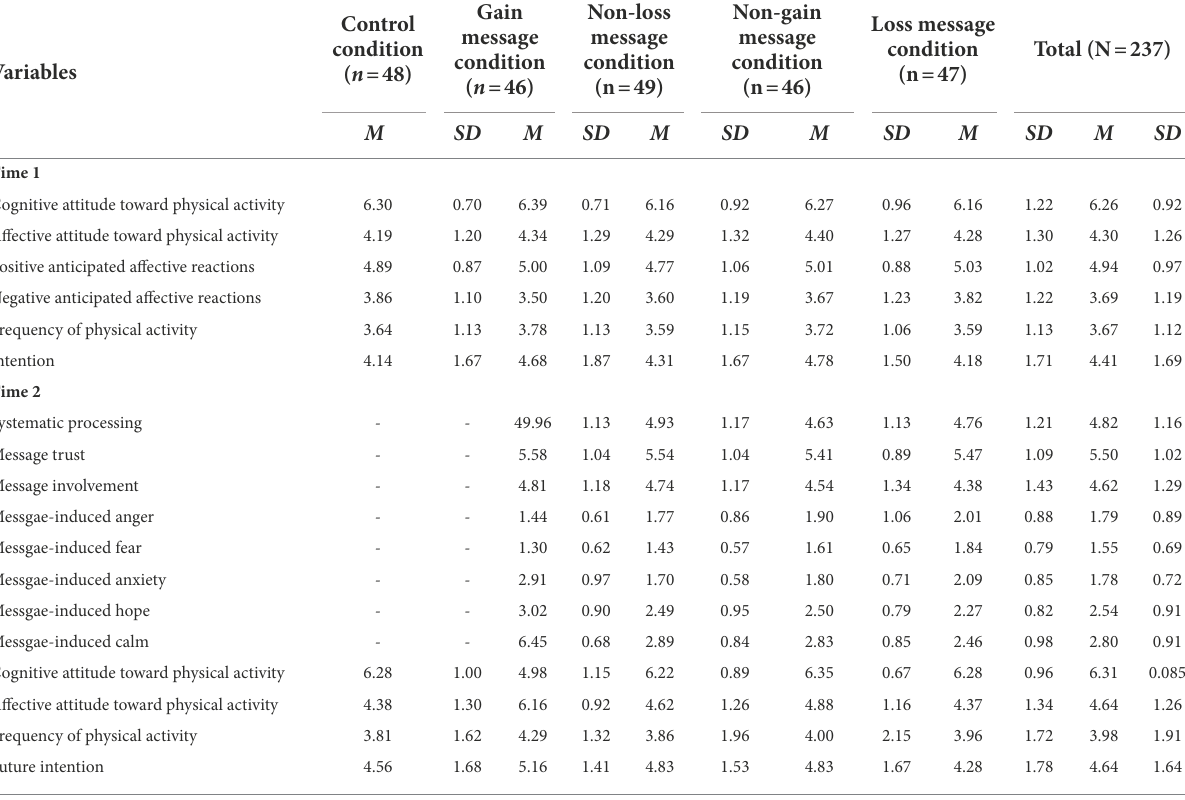
TABLE 3 Means and standard deviations of measured variables in each message condition.